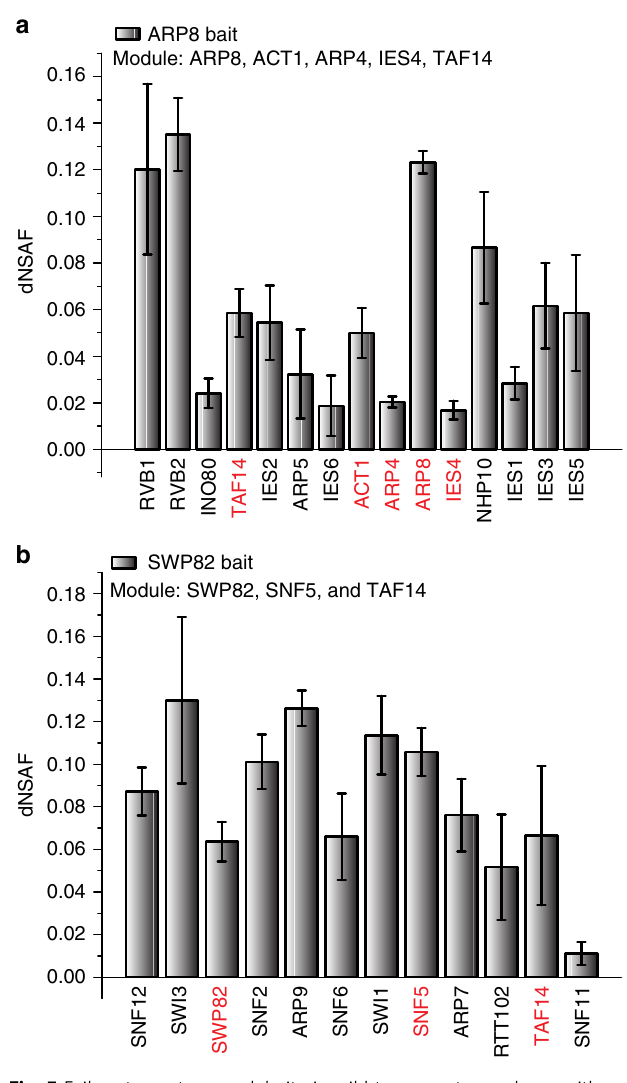
Fig. 5 Failure to capture modularity in wild type-yeast complexes with a standard approach. Distributed normalized spectral abundance factors for the subunits of the INO80 and SWI/SNF complexes in APMS experiments using ARP8 and SWP82 as baits. Protein in red are included in a the ARP8, ACT1, ARP4, IEAS4, and TAF14 module, and b the SWP82, SNF5, and TAF14 module. Error bars represent one standard deviation of the dNSAF values from at least three biological